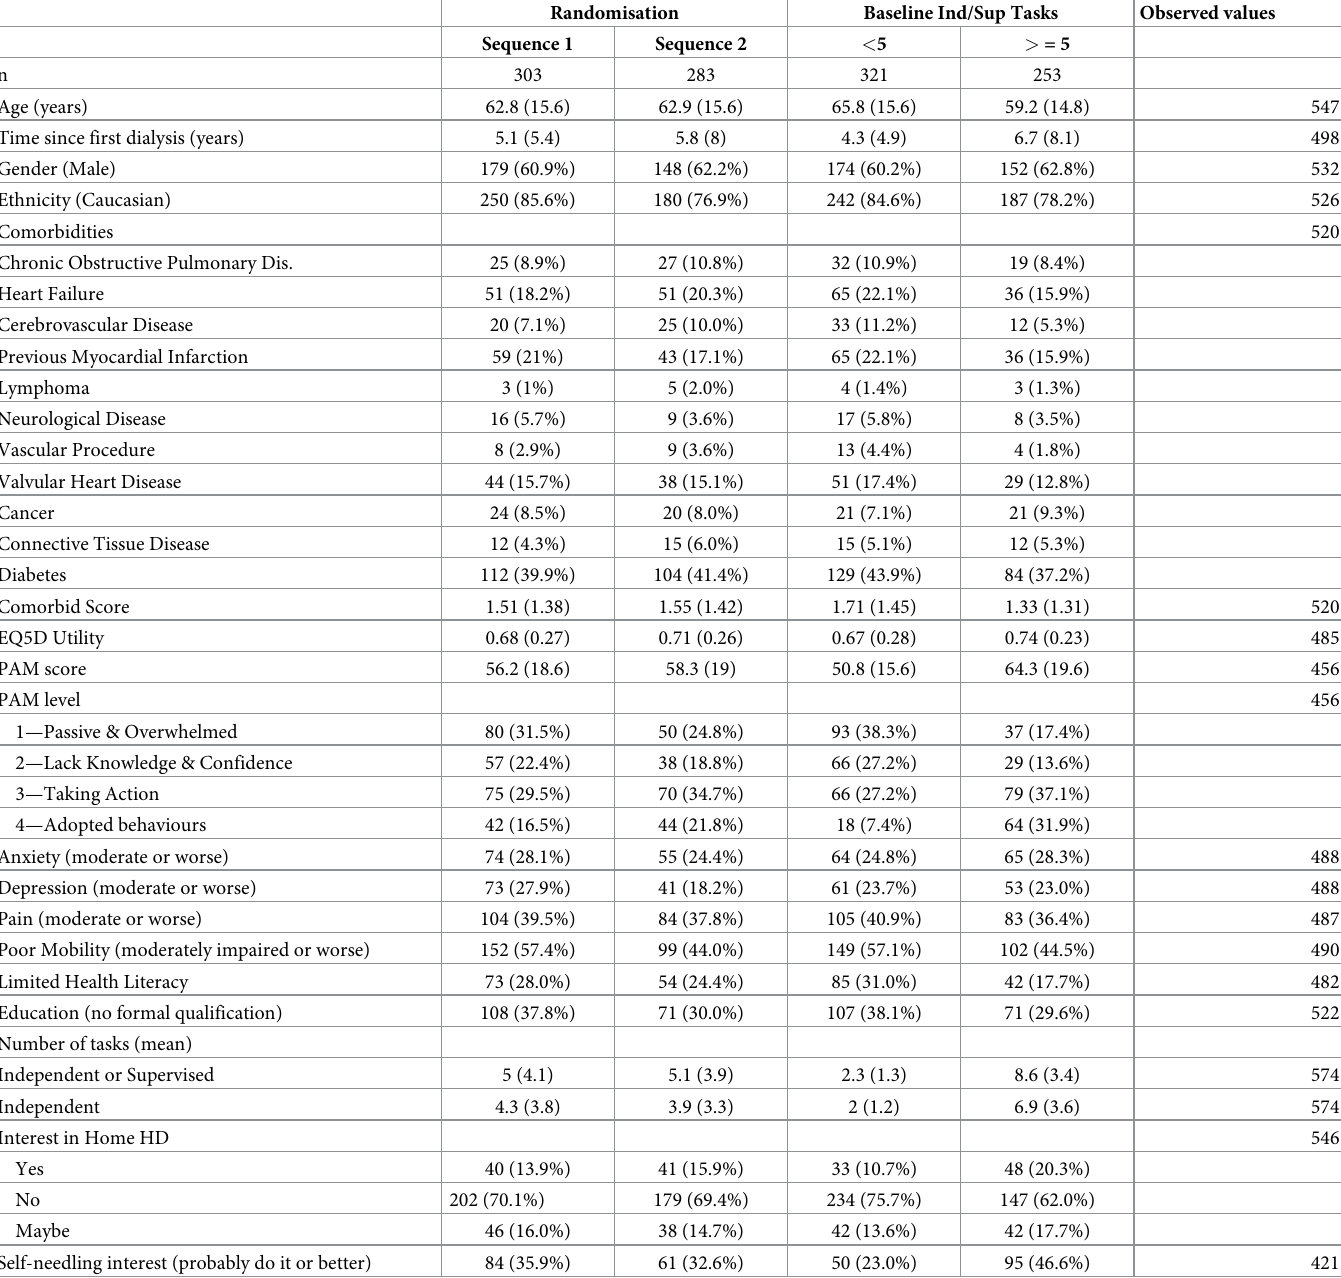
Table 2. Baseline patient